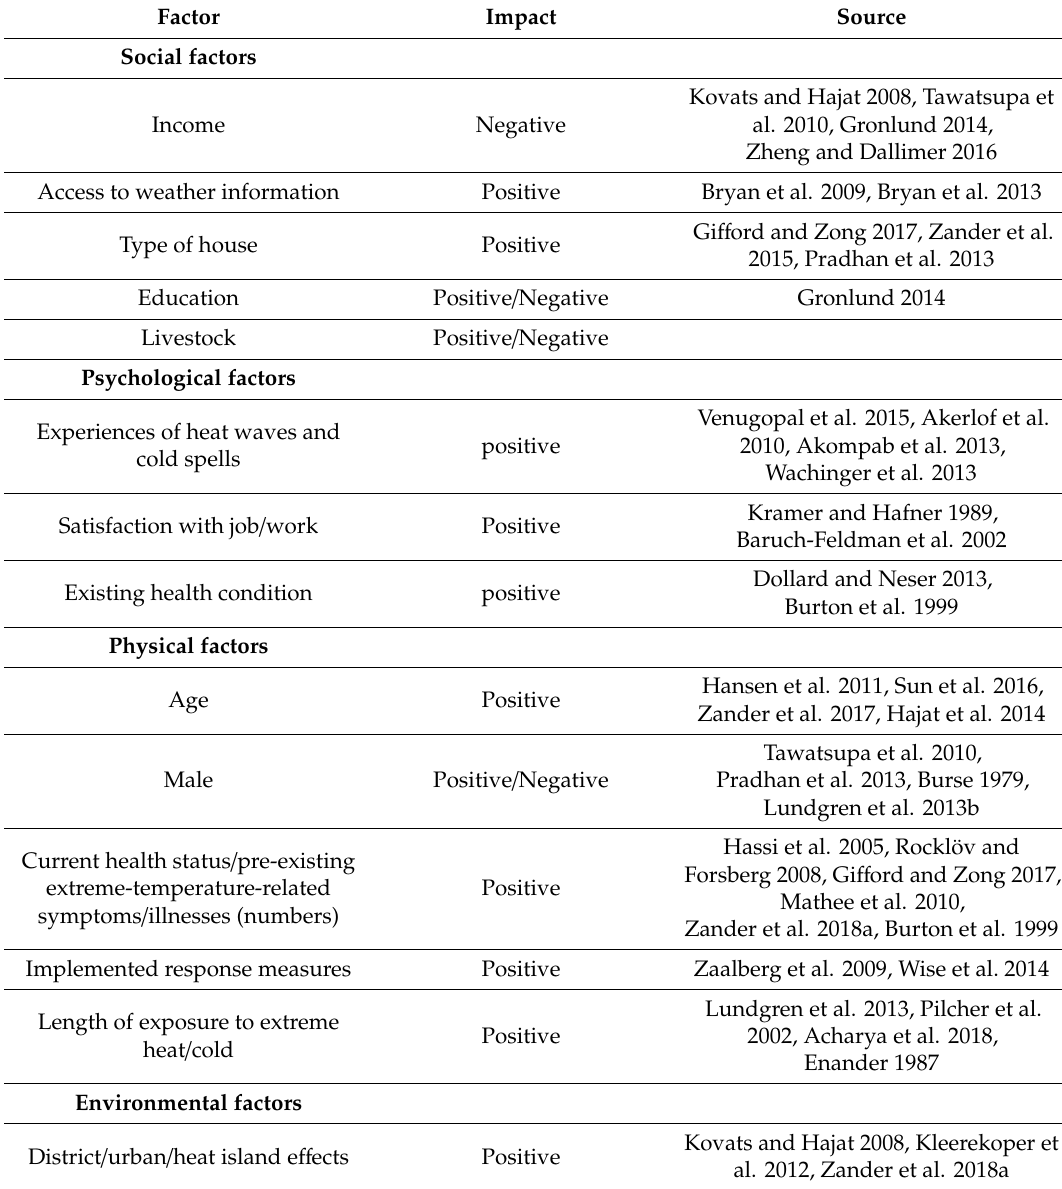
Table 1. Summary of factors determining the heat and cold stress and related productivity